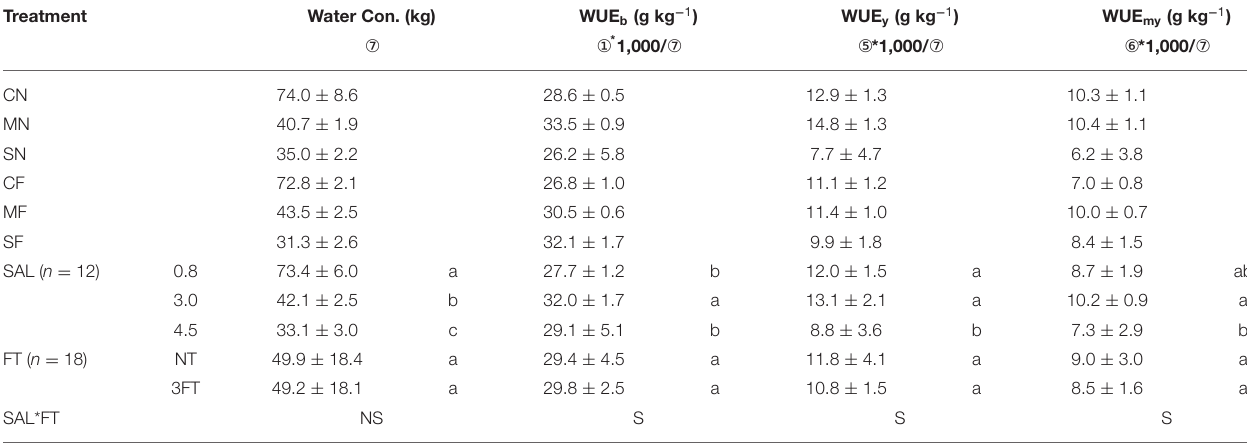
TABLE 4 | Combined treatment on cultivation water consumption (CWC), water use efficiency for biomass (WUE b ), water use efficiency for yield (WUE y ), and water use efficiency for marketable yield (WUE my ). Treatment